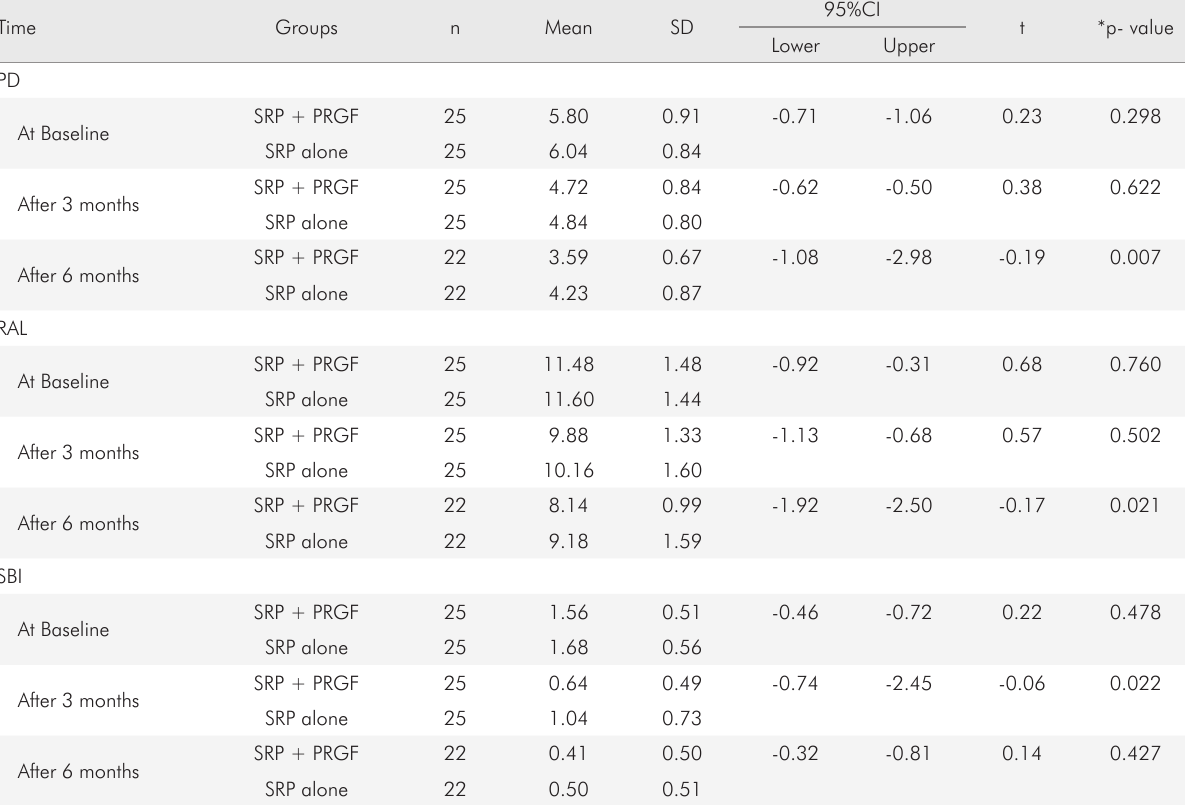
Table 1. Inter-group comparison of clinical outcomes between SRP +PRGF versus SRP alone at baseline, 3 and 6